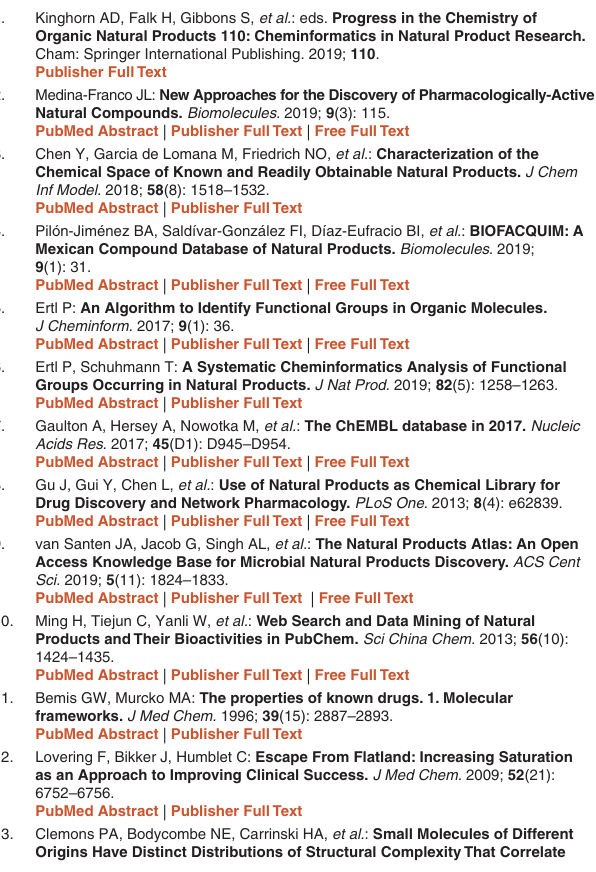
Figshare: Supporting information for “Functional group